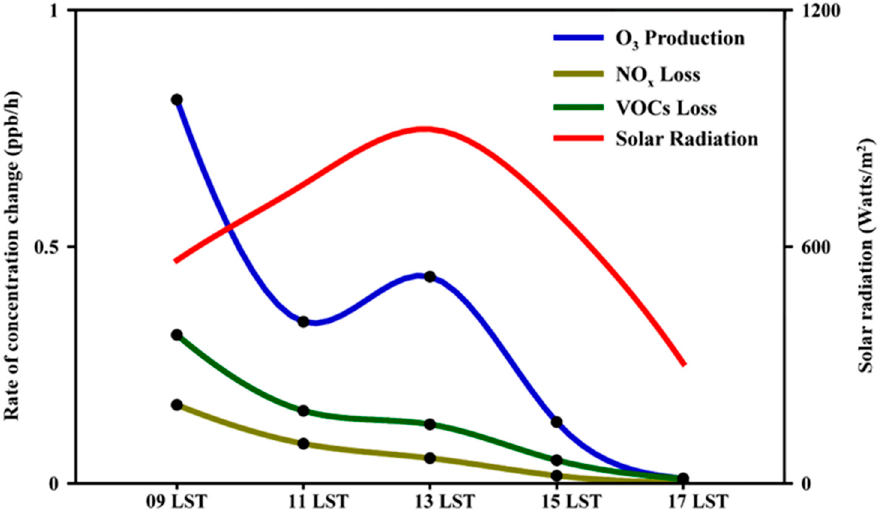
Figure 8. Changes in O3, NOx, and VOC concentrations by chemical reactions and solar radiation during the analysis period (FINN_pbl—BASE).